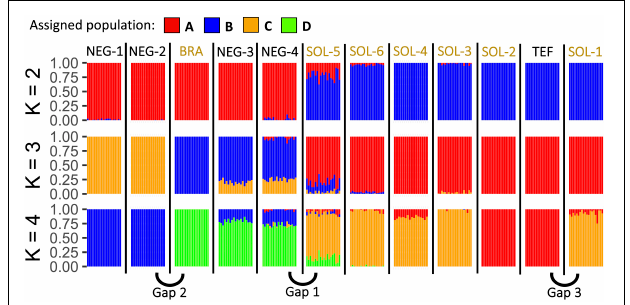
FIGURE 2 | Posterior membership probability plots from Admixture based on the 41,268 SNPs and considering two to four genetic clusters (K). Each individual ( n = 231) is represented by a single vertical line colored proportionally to its posterior membership probability to one of the four genetic clusters considered for this analysis. Samples are wrapped by sampling sites. After K = 4, only one sampling site is being differentiated from the others when increasing the K value. The three genetic gaps detected in the study are